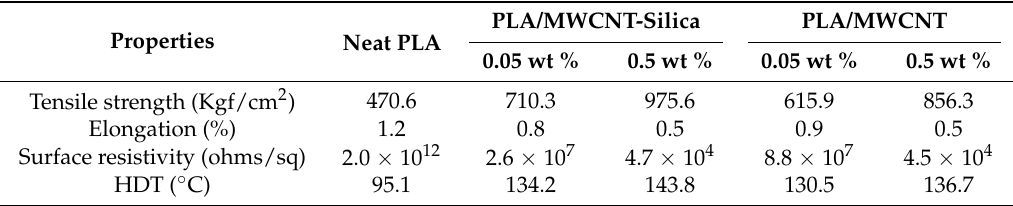
Table 2. Physical properties of neat PLA and PLA-based nanocomposites.